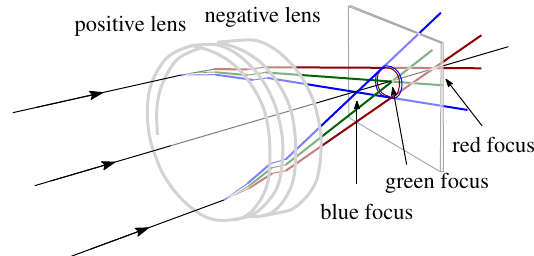
Figure 4: Visual illustration of the longitudal chromatic abbera- tions present within a lens system. A simple lens configuration is illustrated, and the travel path of different wavelength are